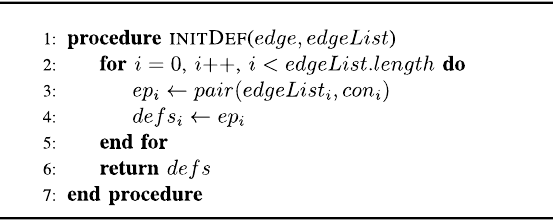
Figure 1. Pseudocode for Initialize Defense.